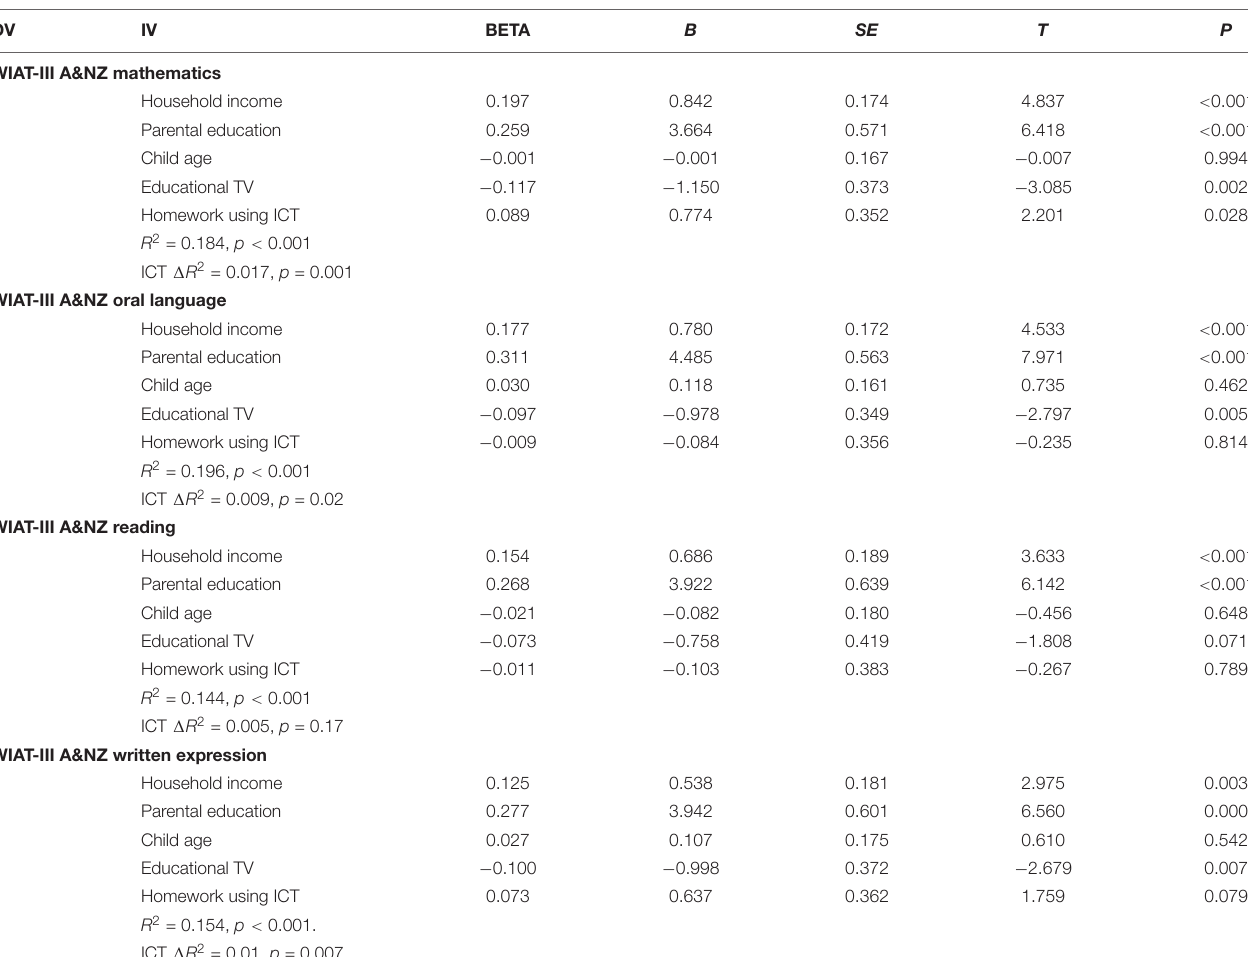
TABLE 5 | Sequential multiple regression of eLearning for WIAT-III A&NZ Academic